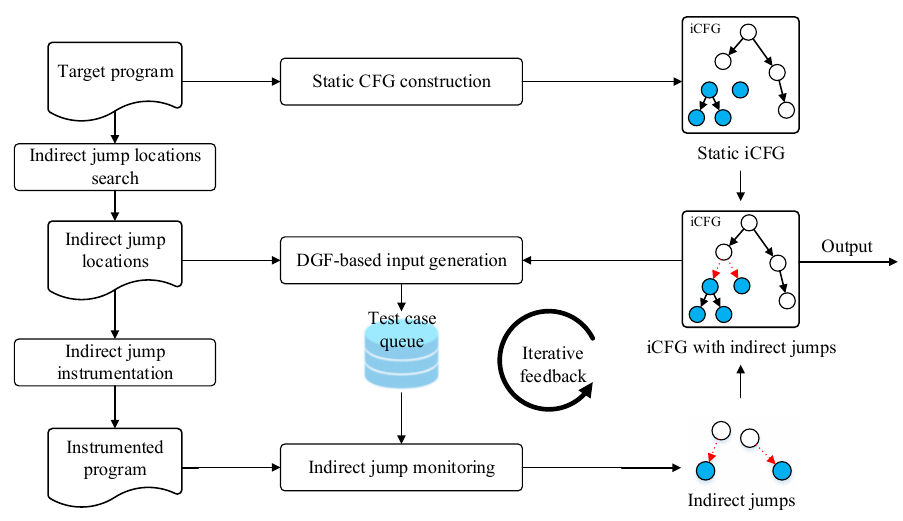
Figure 2. Overview of CFG construction based on directed gray-box fuzzing (DGF).